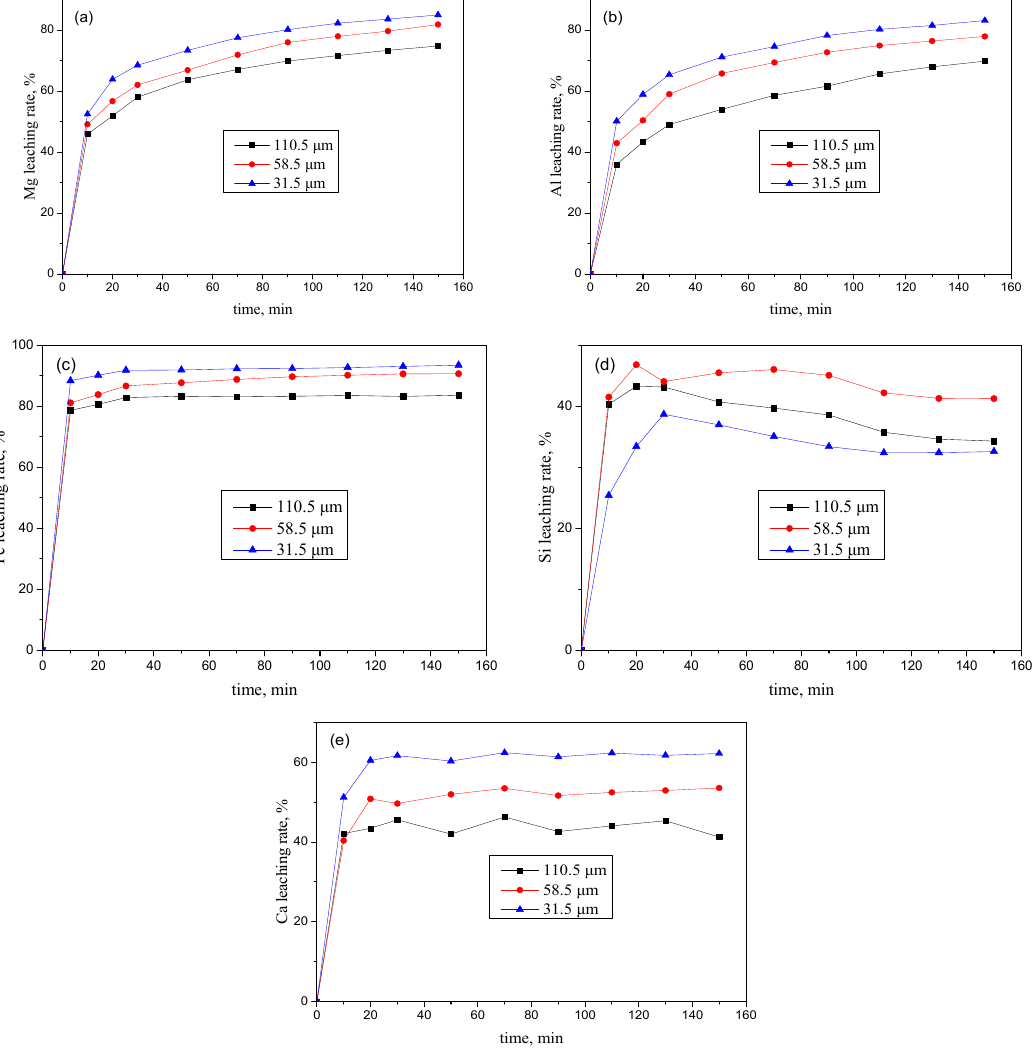
Figure 6. Effects of particle size on the leaching of impurities: ( a ) Mg; ( b ) Al; ( c ) Fe; ( d ) Si; ( e ) Ca.